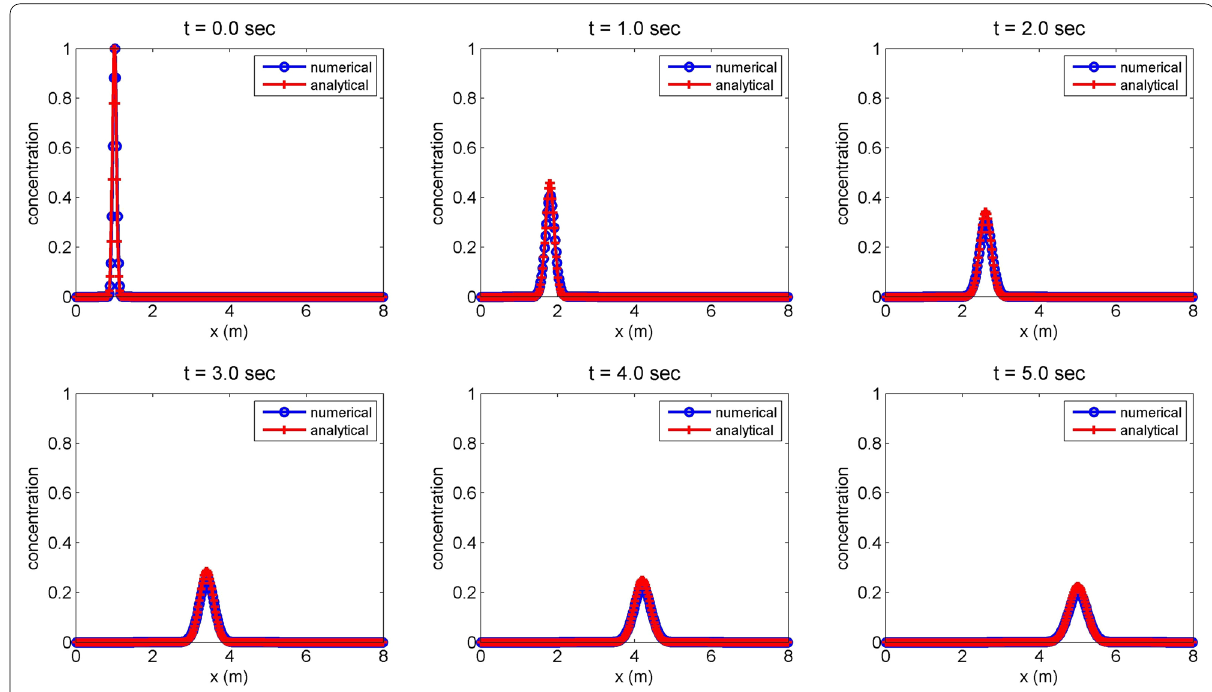
Fig. 2 Analytical (red color) and numerical (blue color) results for the test case